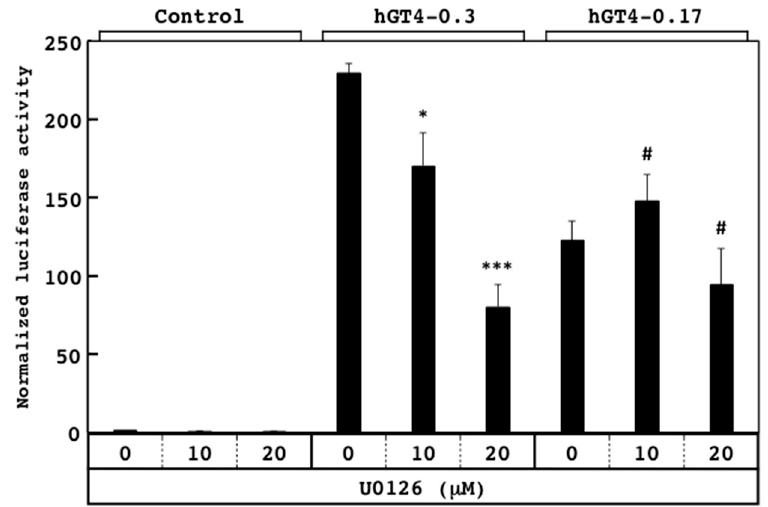
Figure 4. Effects of U0126 on the promoter activities of the hGT4-0.3- and hGT4-0.17-sensor cells using 96-well tissue culture plates. The luciferase activity of the control cells was set at 1.0. Data show means ± S.D. *, p < 0.05 and ***, p < 0.001 against control. #, no significant difference against control.